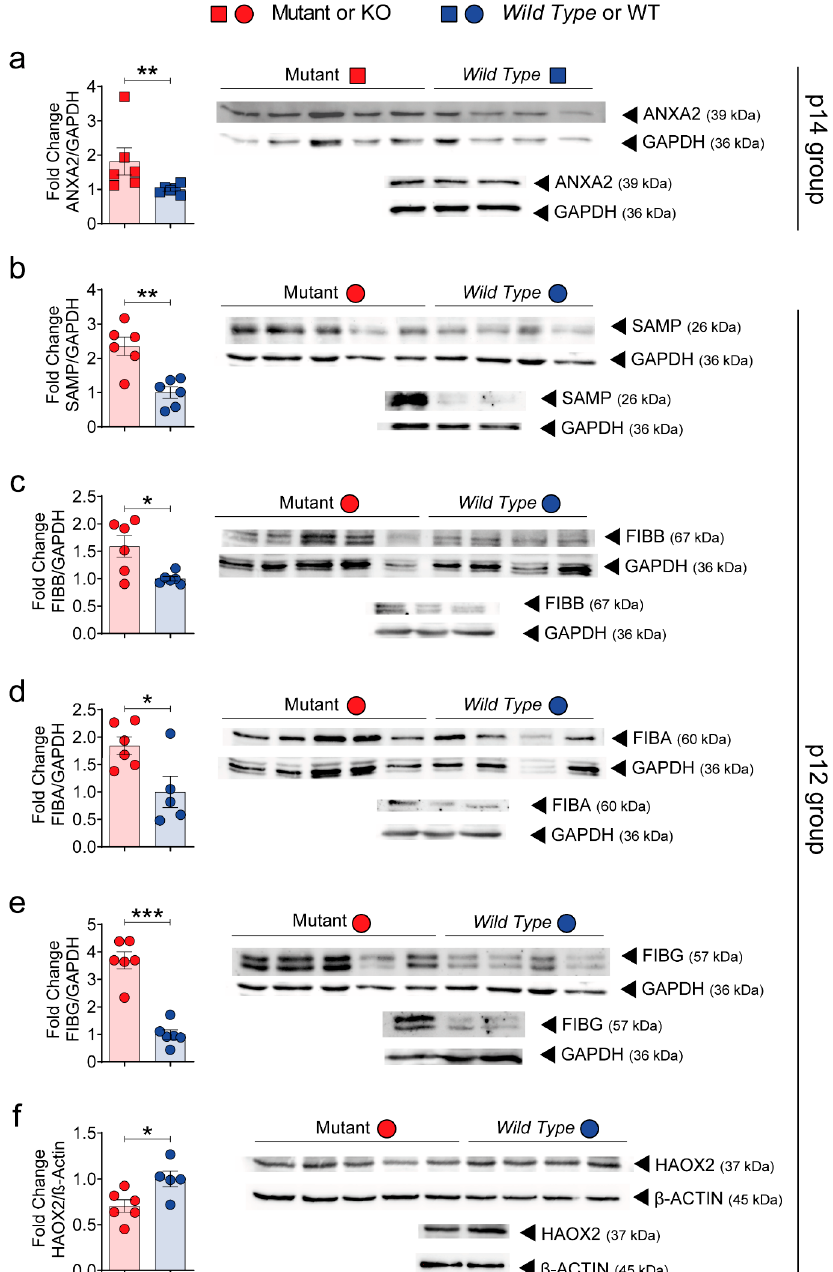
Figure 6. Validation of possible targets by Western blotting . The protein abundance of five possible targets of our quantitative proteomic SWATH-MS data were validated by Western blotting (WB) analysis. WB of up-regulated selected p14 target annexin A2 (ANXA2) ( a ); up-regulated p12 targets amyloid p component, serum (SAMP) ( b ), fibrinogen beta chain (FIBB) ( c ), fibrinogen alpha chain (FIBA) ( d ), fibrinogen gamma chain (FGG) ( e ); down-regulated p12 target hydroxyacid oxidase 2 (HAOX2) ( f ). n = 6 was used for each protein group. GAPDH or β -ACTIN were used as housekeeping genes. Bars represent means ± SEM. Student’s t -test with two-tail was used and a value of p < 0.05 was considered significant. * p < 0.05, ** p < 0.01, *** p < 0.001.